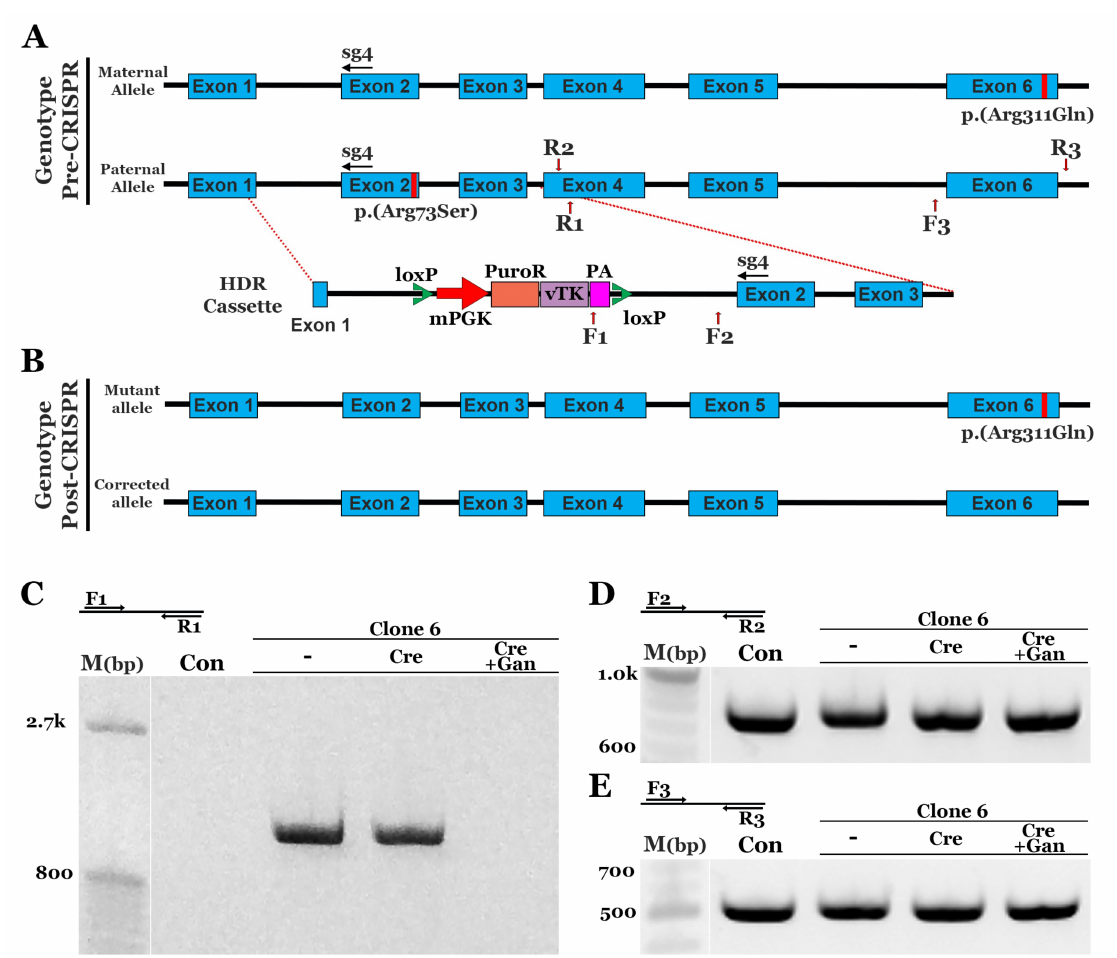
Figure 3. CRISPR-based homology-directed repair of the p.(Arg73Ser) mutation in patient-derived iPSCs. ( A ): Schematic diagram depicting the genotype pre-CRISPR correction and the HDR cassette used to repair the p.(Arg73Ser) mutation: Homologous sequence upstream and downstream of the loxP flanked puromycin resistance (PuroR), viral thymidine kinase (vTK), and SV40 polyadenylation (PA). ( B ): Schematic depicting the genotype following CRISPR-based repair: One corrected allele and one mutant allele harboring the p.(Arg311Gln) mutation. ( C ): Representative gel image of the genomic